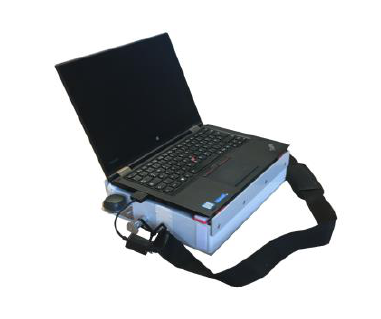
Figure 6: Mobile Ground and Control